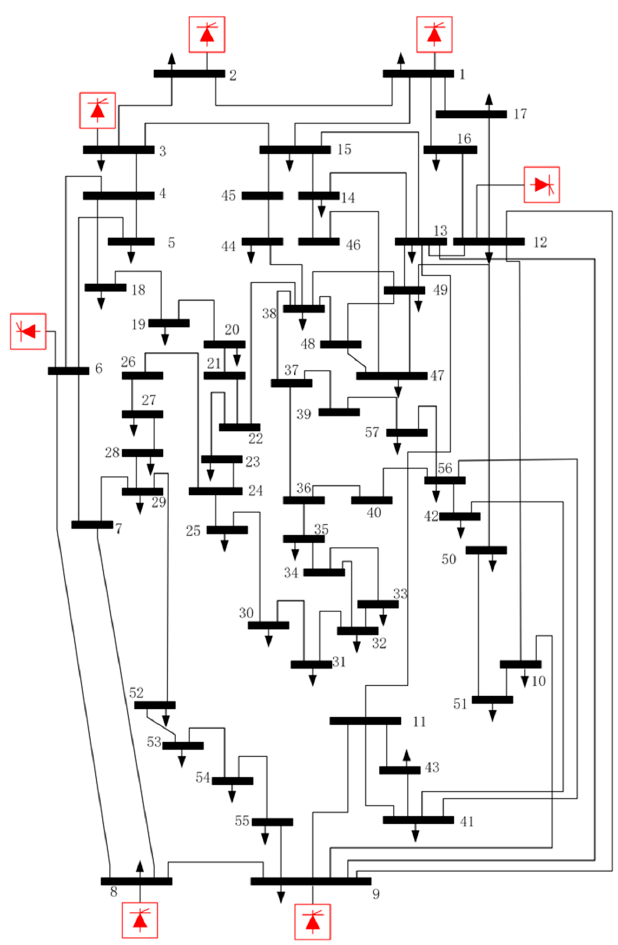
Figure 4. Modified IEEE 57-bus system.